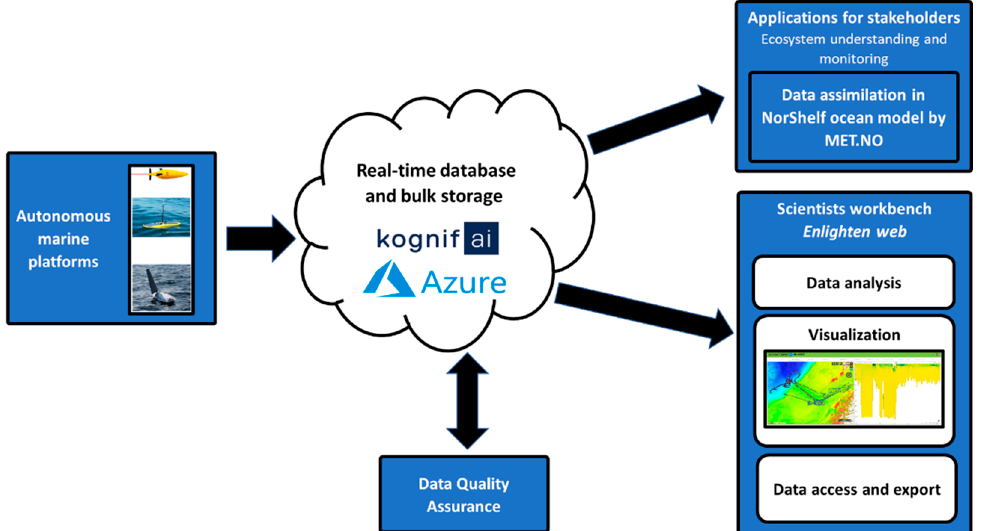
Figure 3. Overview of the e-infrastructure implemented in the GLIDER project. The gliders send time-series data via satellite links, which are stored in the Kognifai digital ecosystem. Here, servers at Niva automatically perform data quality control and the data are available through a web portal. The NorShelf ocean model also assimilates data, improving ocean predictions. Satellite links are a potential communication resource not used in their presented work due to high costs.